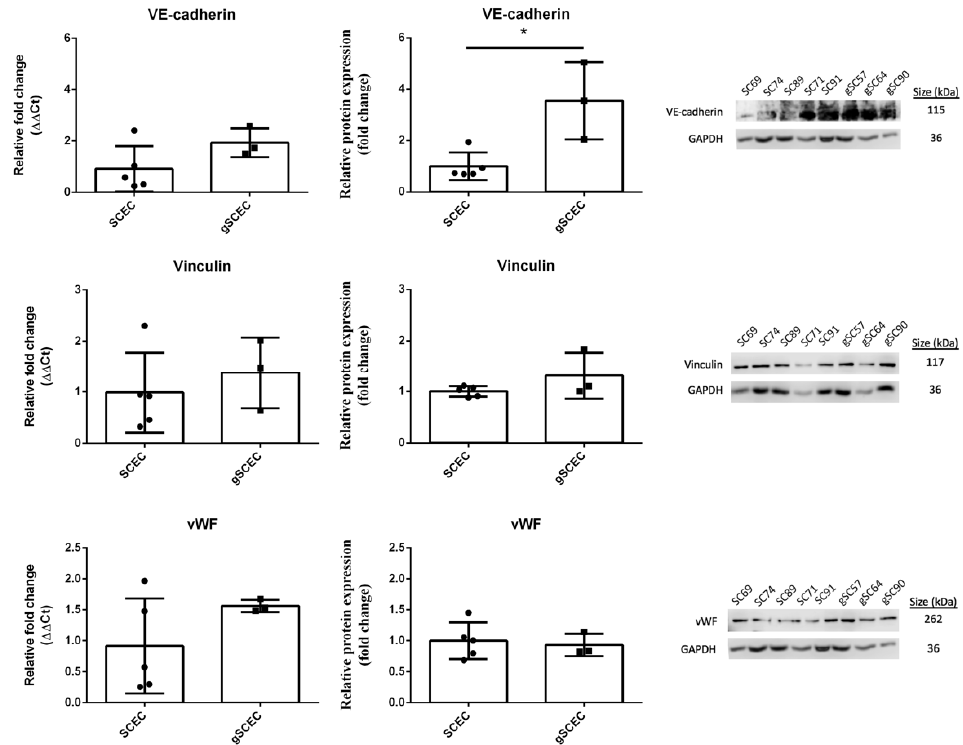
Figure 2. Comparison of endothelial marker expression in healthy versus glaucomatous SCECs. Shown are mRNA transcript (left column) and protein (middle column) quantification of the endothelial markers VE-cadherin, vinculin and vWF in gSCECs relative to healthy SCECs. Representative blots are shown in right columns. A significant increase in VE-cadherin protein ( p = 0115) expression was observed in gSCECs, compared to SCECs. No significant increase in vinculin and vWF transcript ( p > 0.05) and protein ( p > 0.05) expression was observed. Mean +/- SD is shown above with each data point representing an individual biological sample, n = 5 for SCEC and n = 3 for gSCEC. Statistical analysis was carried out using an unpaired Student’s t -test and statistical significance was indicated by * = ( p <